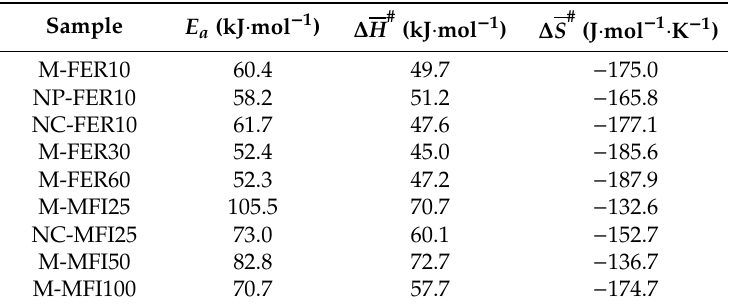
Table 4. Kinetic parameters of investigated